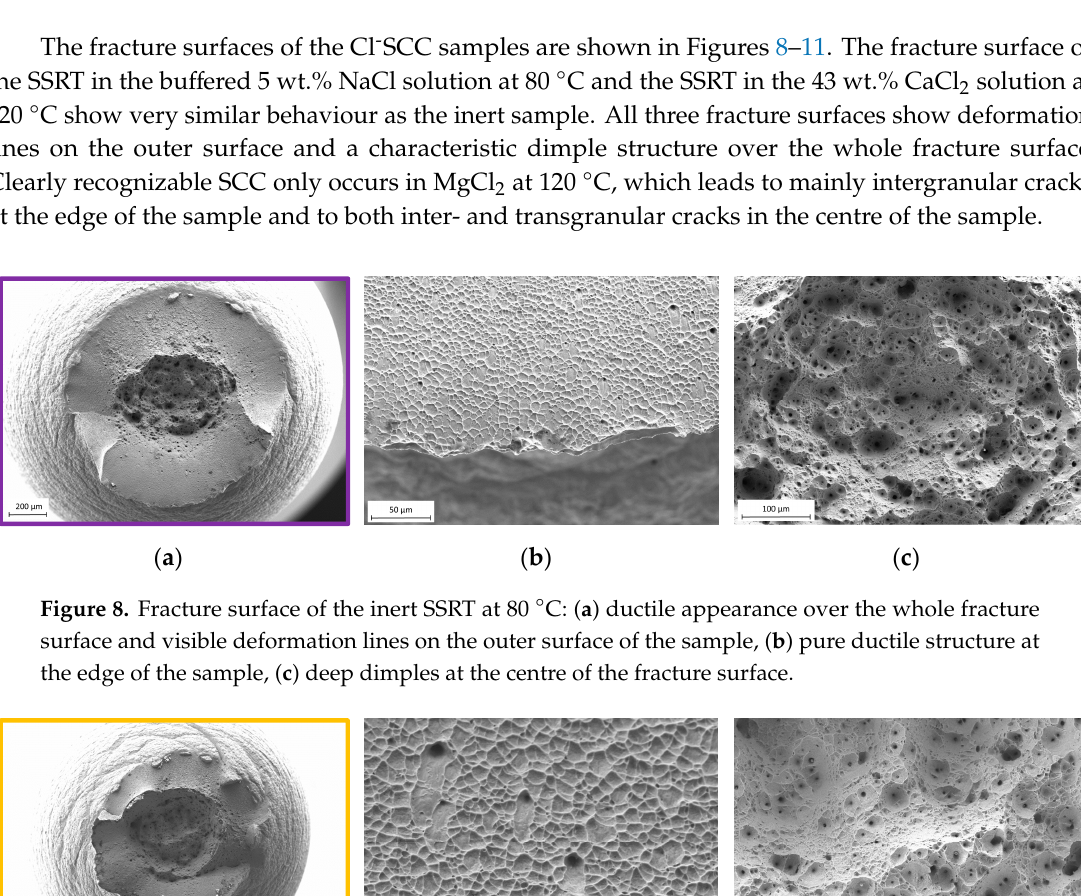
Figure 7. Cl - SCC results for different solutions and optical microscopy of selected samples after SSRT testing: ( a ) Glycerine, 120 °C, ( b ) 5 wt.% NaCl pH 3.5, 80 °C, ( c ) 43 wt.% CaCl 2 , 120 °C, ( d ) 42 wt.% MgCl 2 , 120 °C.